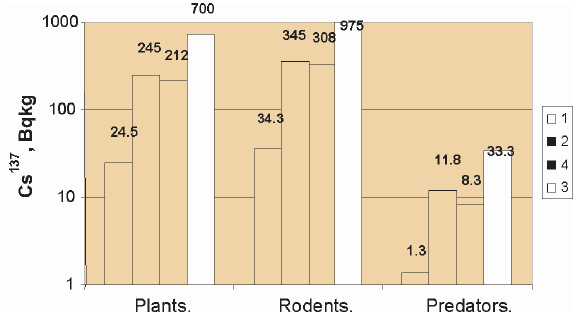
137 Cs specific